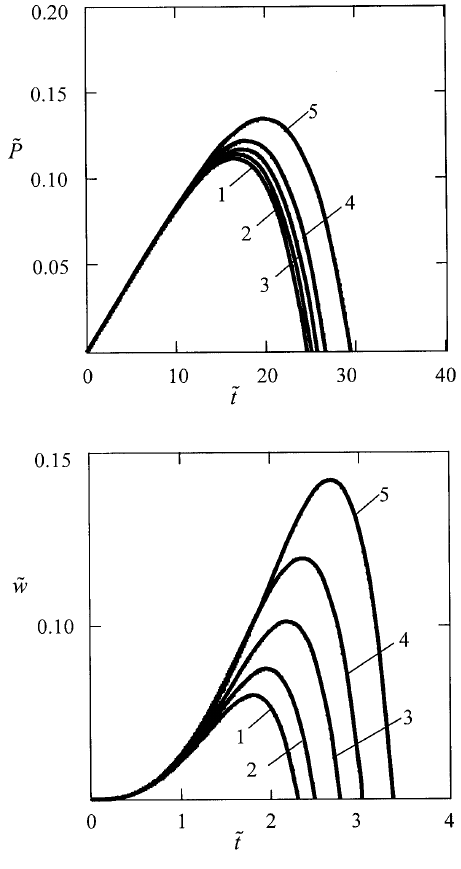
Fig. 2. The dimensionless time dependence of the dimensionless contact force and deflection at E θ /E r = 2 for a = 1 (curve 1), 0.75 (curve 2), 0.5 (curve 3), 0.25 (curve 4), and 0 (curve